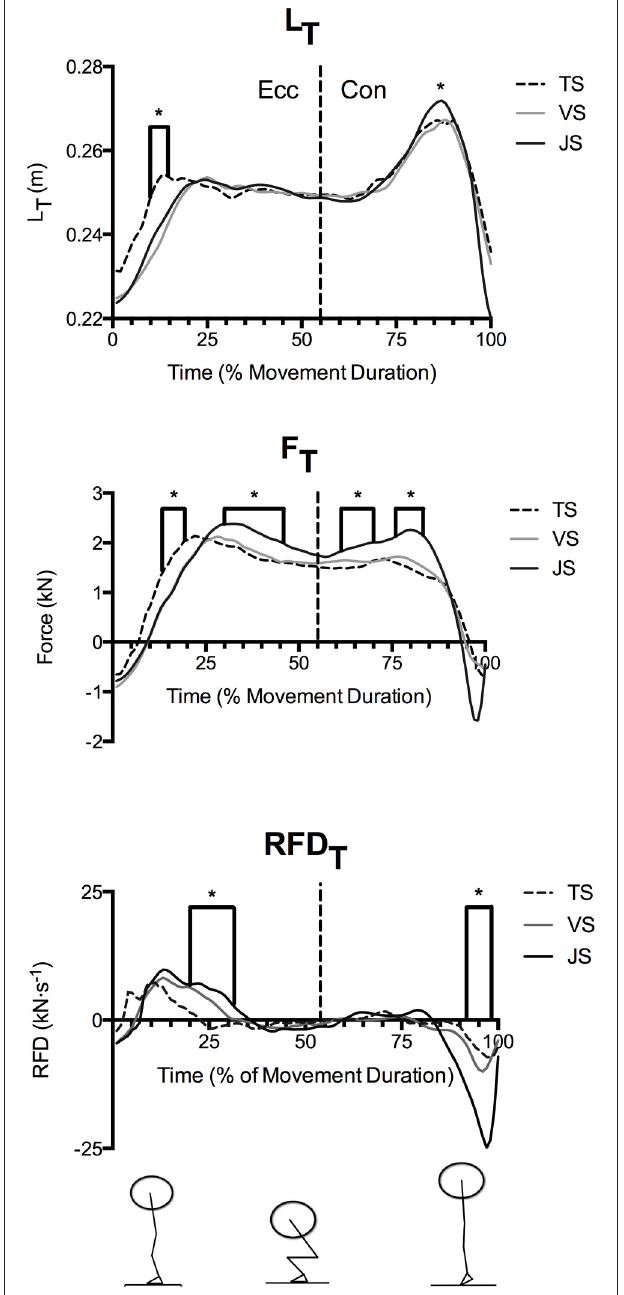
FIGURE 3 | Mean quadriceps tendon length (L T ) and patellar tendon force (F T ) and rate of force development (RFD T ) during parallel-depth slow-tempo (TS), volitional speed (VS), and jump (JS) squat conditions ( n = 10). Range of SEM at 20, 40, 60, 80, and 100% movement duration for L T (2.6–3.5cm), F T (0.46–1.87kN) and RFD T (0.70–6.30 kN · s − 1 ) are reported. *Indicates significant difference between TS and JS.